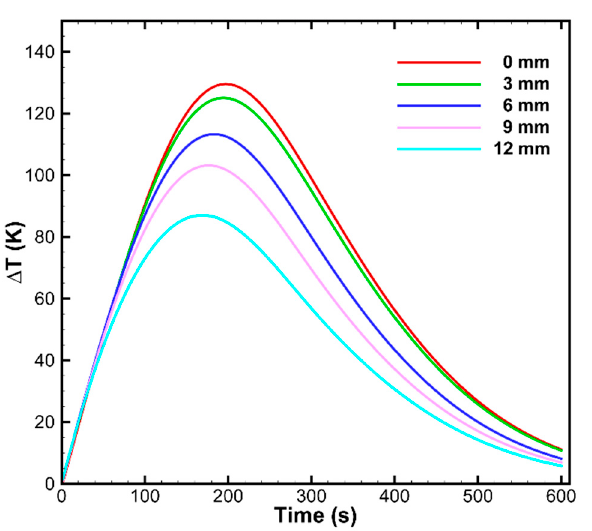
Figure 17. The profile of ∆ T at various radial positions ( x = 45 mm) over time.